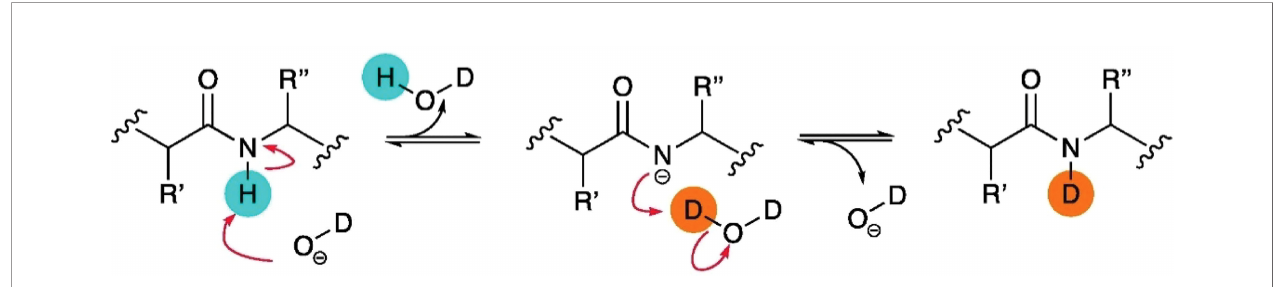
FIGURE 3 | Schematic of base catalysis HDX of amide backbone protons in solution. Figure is reproduced from